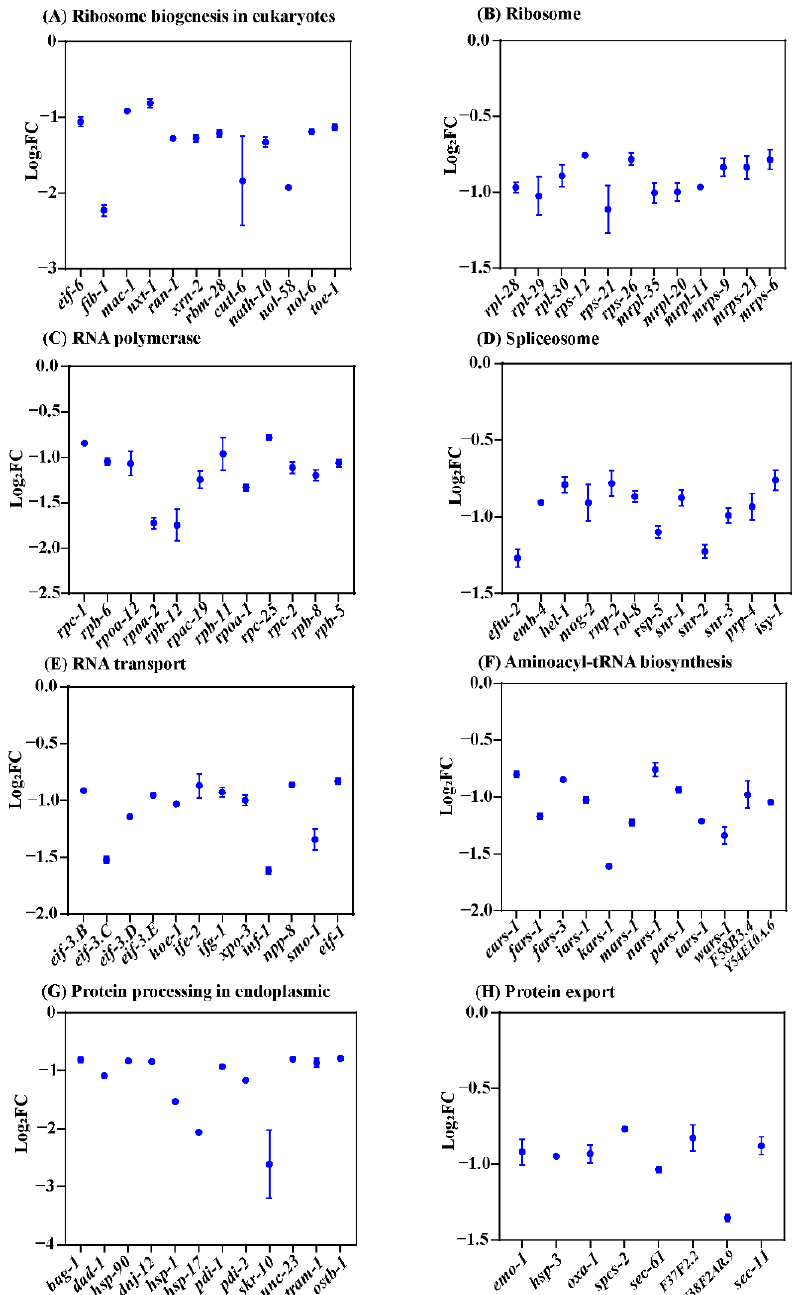
Figure 5. The expression of down-regulated pathway related genes of C. elegans on CeMM. ( A ) Ribosome biogenesis in eukaryotes-related genes in C. elegans . ( B ) Ribosome genes in C. elegans . ( C ) RNA polymerase genes in C. elegans . ( D ) Spliceosome-related genes in C. elegans . ( E ) RNA transport- related genes in C. elegans . ( F ) Aminoacyl-tRNA biosynthesis-related genes in C. elegans . ( G ) Protein